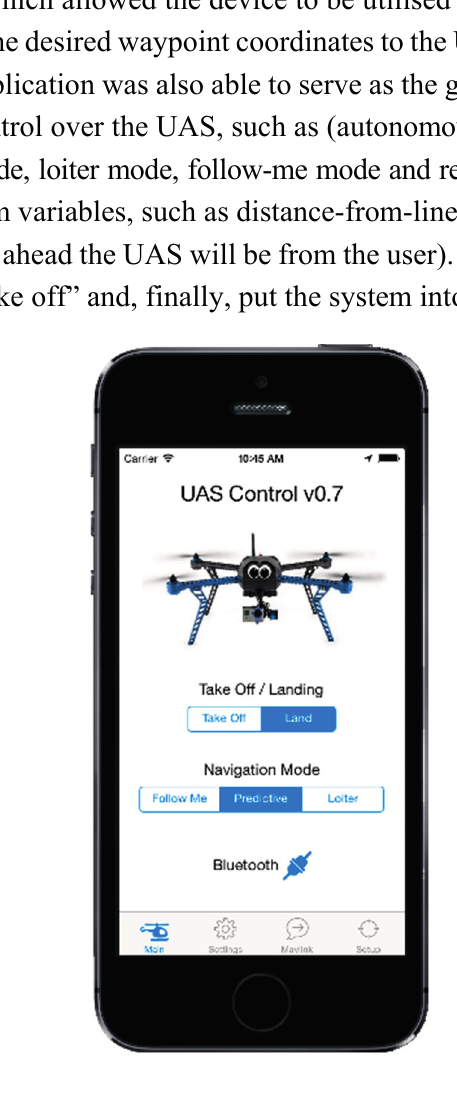
Figure 7. iOS ground control station (GCS) application used for iPhone